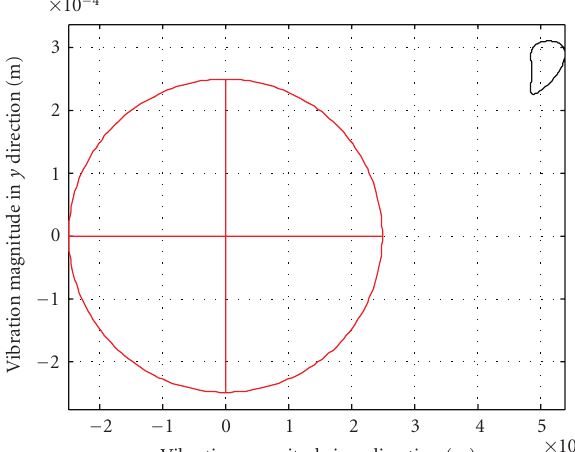
Figure 16: Shaft orbit (0.8mm, 45 ◦